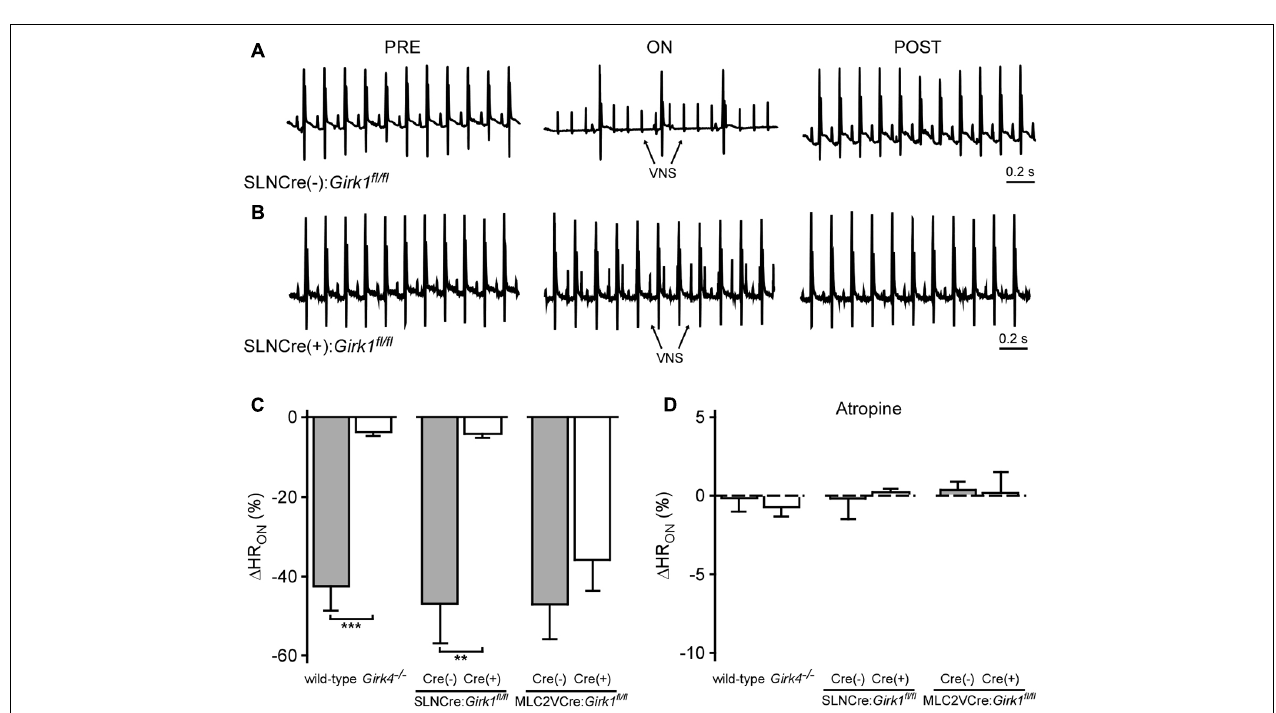
FIGURE 4 | Impact of whole-heart and tissue-specific GIRK channel ablation on VNS-induced decrease in HR. (A,B) Representative ECG segments from anesthetized SLNCre(–): Girk1 fl / fl (Top) and SLNCre(+): Girk1 fl / fl (Bottom) mice prior to (PRE, Left), during (ON, Middle), and after (POST, Right) VNS. The small spikes observed during VNS (ON) correspond to electrical stimulation artifacts. (C) Relative change in HR ( (cid:49) HR ON ) during VNS. A significant difference in (cid:49) HR ON was observed between wild-type ( n = 9) and Girk4 − / − ( n = 10) mice ( t 17 = 6.5; ∗∗∗ P < 0.001), as well as SLNCre(–): Girk1 fl / fl ( n = 6) and SLNCre(+): Girk1 fl / fl ( n = 5) mice ( t 9 = 3.9; ∗∗ P < 0.01). No difference was seen between MLC2VCre(–): Girk1 fl / fl ( n = 6) and MLC2VCre(+): Girk1 fl / fl ( n = 8) mice ( t 12 = 0.95; P = 0.36). (D) Relative change in HR ( (cid:49) HR ON ) during VNS, in the presence of atropine (2.0 mg/kg IP). There were no significant differences between wild-type ( n = 4) and Girk4 − / − ( n = 6) mice ( t 8 = 0.6; P = 0.59), SLNCre(–): Girk1 fl / fl ( n = 6) and SLNCre(+): Girk1 fl / fl ( n = 4) mice ( t 8 = 0.2; P = 0.82), and MLC2VCre(–): Girk1 fl / fl ( n = 6) and MLC2VCre(+): Girk1 fl / fl ( n = 4) mice ( t 8 = 0.2, P =